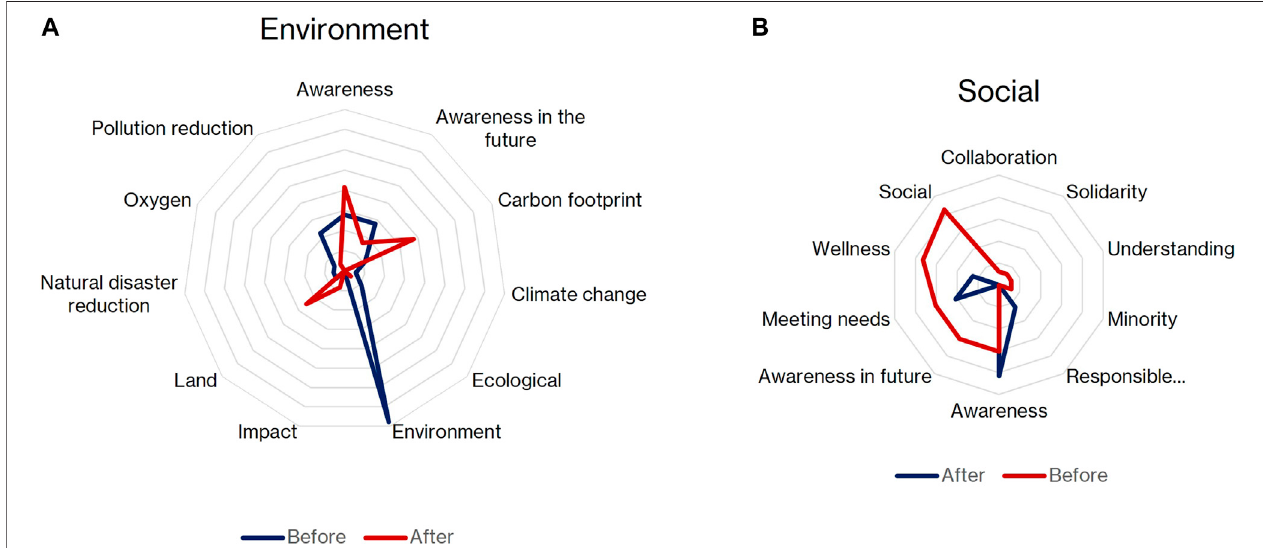
FIGURE 5 | Semantic Richness According to the Category dimensions of Sustainability (A) environment (B)